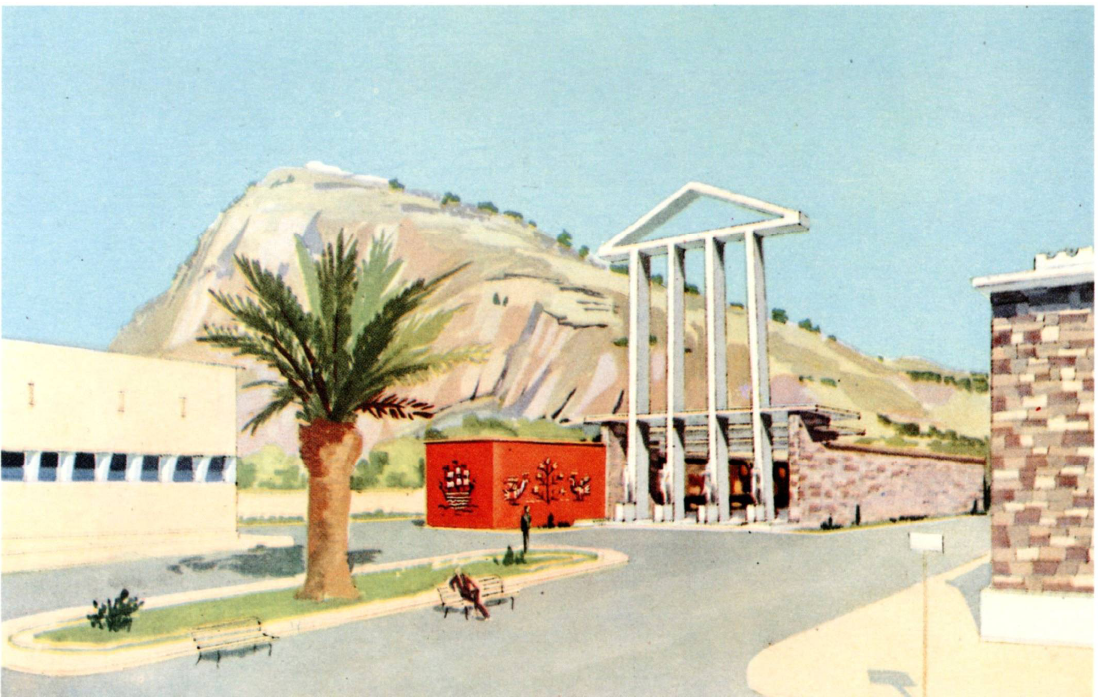
Figure 5. The Pavilion G, project for Greece, Architects Demetrio and Alexandra Moretis,